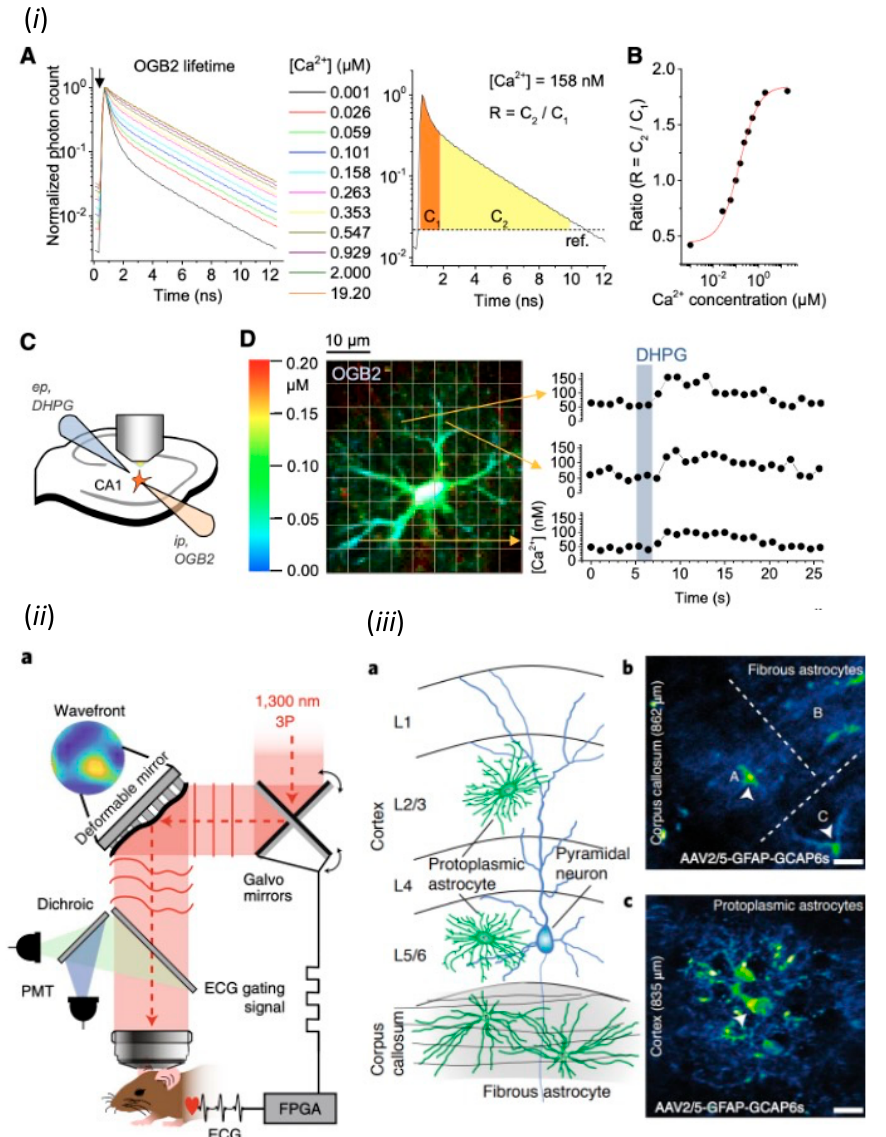
Figure 2. Physiological studies of astrocytes by modern microscopy. ( i ) Imaging of absolute Ca 2+ concentration in in vivo astrocytes by 2P-FLIM. Adapted from Figure 1 in King et al., 2020 [22]. ( ii ) Three-photon microscopy with adaptive optics and ( iii ) its application for Ca 2+ imaging of protoplasmic astrocytes in cerebral gray matter and fibrous astrocytes in white matter. (Scale bar, 20 µm). ( ii ) and ( iii ) were adapted with permission from Figure 1 and Figure 4 in Streich et al., 2021 [32], respectively.